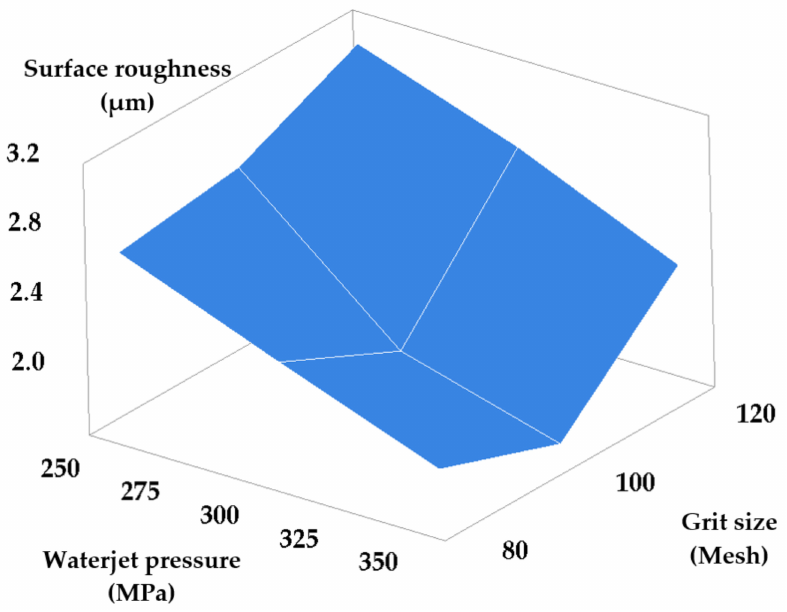
Figure 8. Roughness versus waterjet pressure and grit size set-point